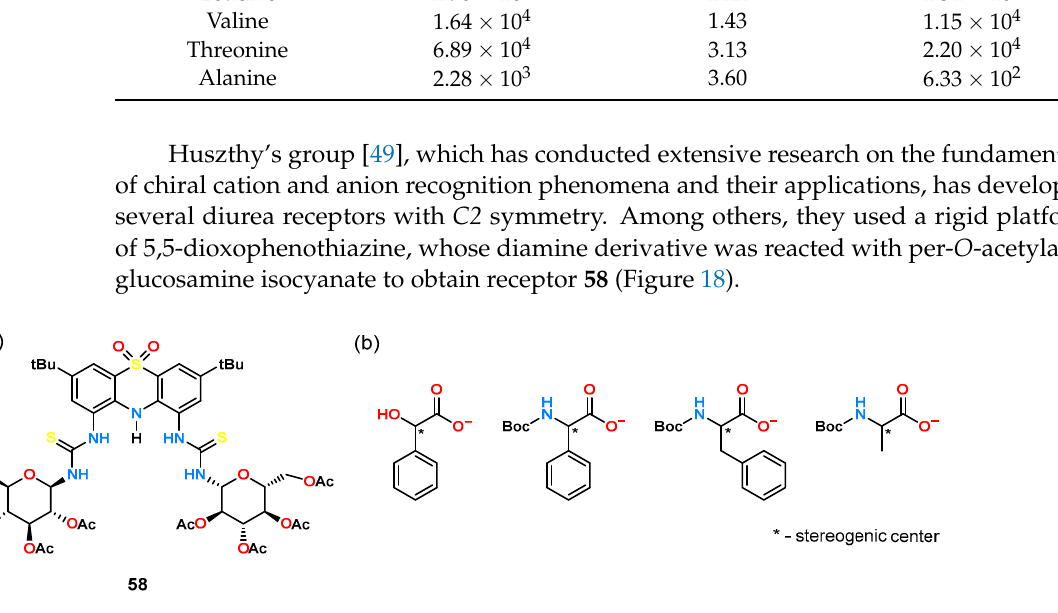
Figure 18. ( a ) Phenothiazine diurea receptor 58 and ( b ) evaluated hydroxy and amino acids.